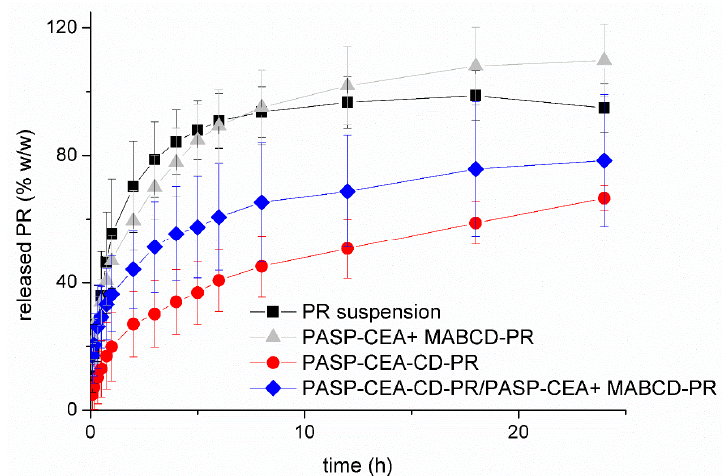
Figure 6. Drug release from the formulations containing PR. Cumulative mean values and standard deviations (S.D.), n = 3.